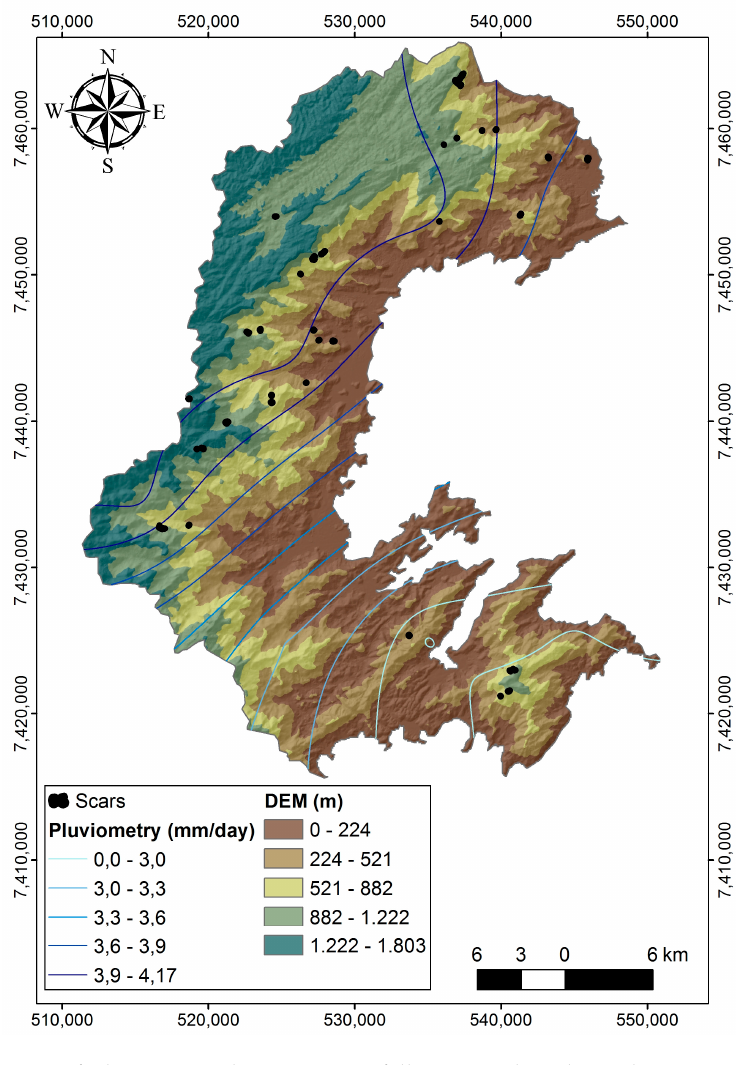
Figure 4. Maps of elevation with TRMM rainfall contour line-derived average daily rainfall for 2000–2007. ISPRS Int. J. Geo-Inf. 2017 , 6 , 289 Table 4. Correlation matrix for landslide frequency in terms of critical cohesion and average rainfall.